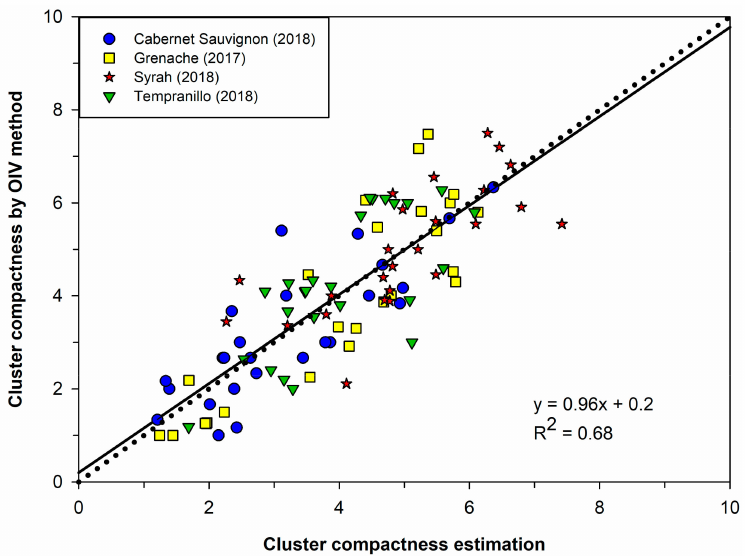
Figure 7. Performance of the GPR model on the test set (100 clusters); correlation between the cluster compactness estimation performed by the model and the OIV ratings (reference method) evaluated visually by the panel of